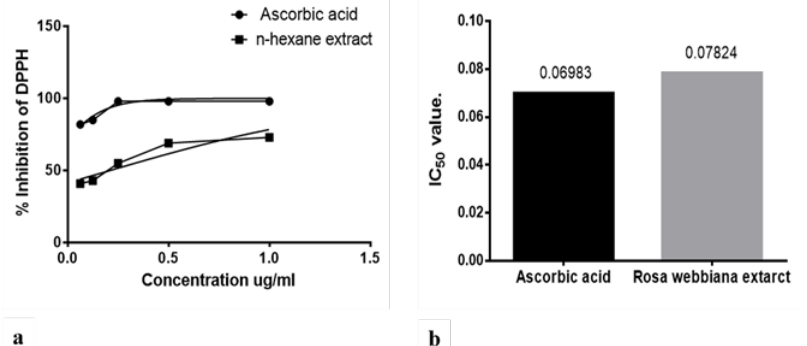
Figure 2. ( a ) DPPH scavenging by n -hexane extract of Rosa webbiana at different concentrations ( b ) IC 50 value for ascorbic acid and Rosa webbiana . No significant difference from control (ascorbic acid) could be observed.